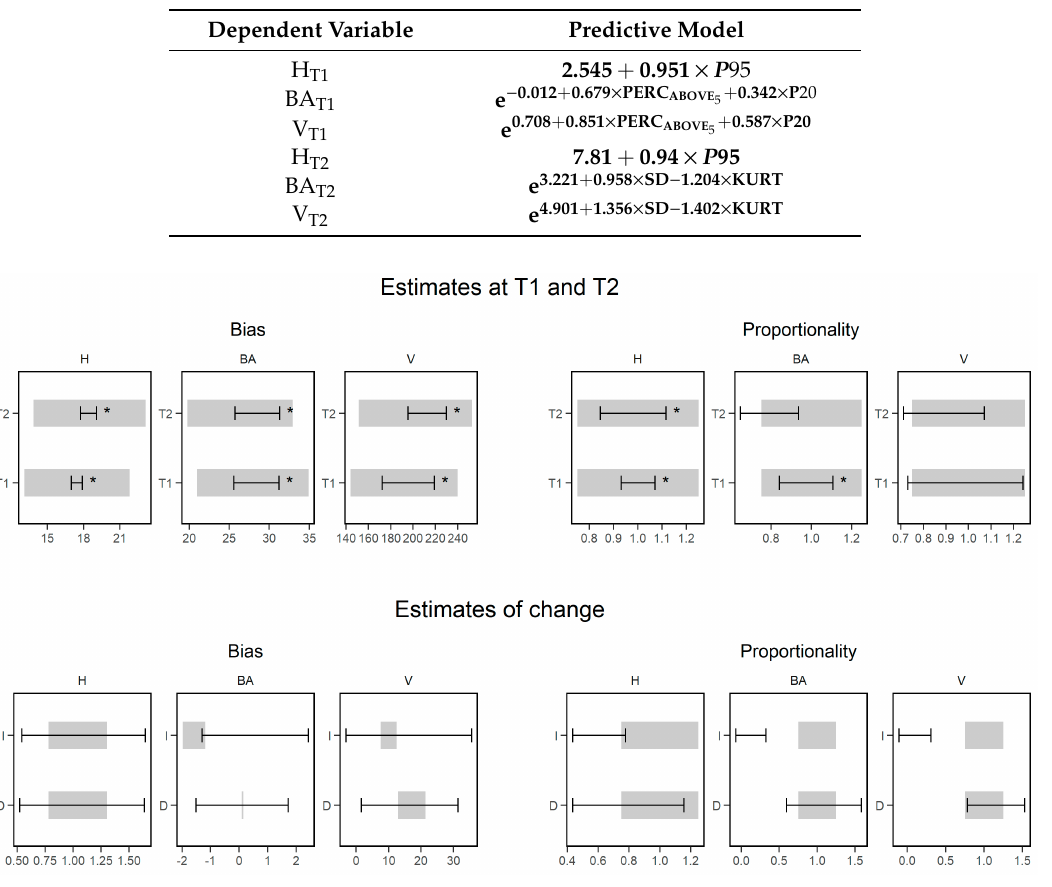
Table 2. Predictive models for top height (H), basal area (BA), total plot volume (V). Dependent variables denoted with T1 were modeled using ALS data acquired at T1 (2006–2008), while T2 variables were modeled using DAP data from T2 (2015). Predictor variables used in these models included the 20th percentile of point heights (P20), the 95th percentile of point heights (P95), the proportion of points above 5 m (PERC_ABOVE_5), the standard deviation of point heights (SD), and the kurtosis of point heights (KURT).